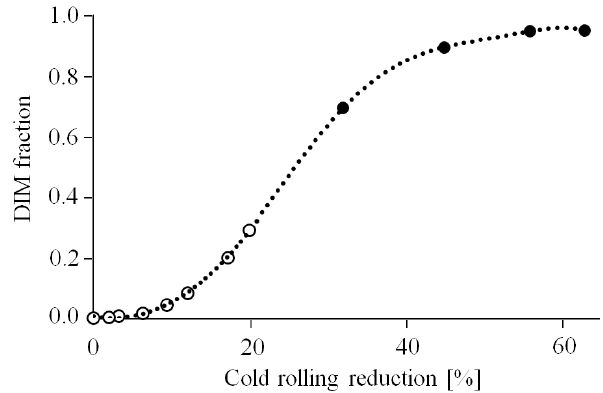
Figure 1. The evolution of the deformation-induced martensite (DIM) fraction in a 301LN under the present cold rolling conditions. Open symbols are results from Feritscope and solid from X-ray diffraction (XRD) measurements. Table 2. Grain sizes and phase fractions of the studied structures.